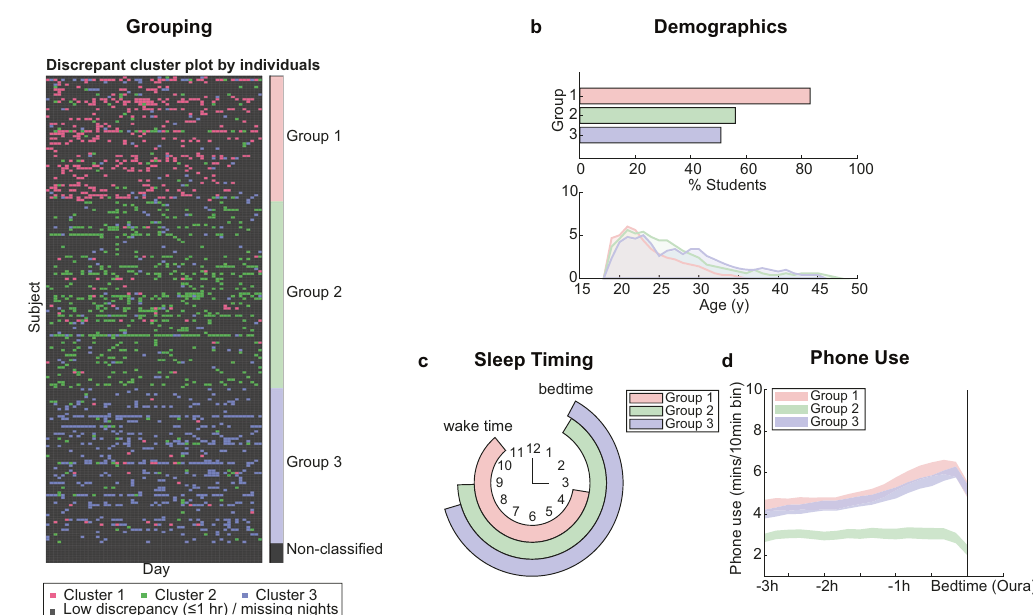
Fig. 4 Individual phenotyping based on discrepancy clusters. a Distribution of high-discrepancy nights over individual participants (rows) plotted for each day (columns) of the 8-week monitoring period. High-discrepancy nights were grouped according to cluster membership. b Percentage students, and age distribution of resulting groups. c Sleep characteristics as quanti fi ed on low-discrepancy nights. d Pre-bedtime phone usage (Tappigraphy derived) in the window 3 h prior to bedtime (Oura de fi ned). Shaded areas depict mean ± 1